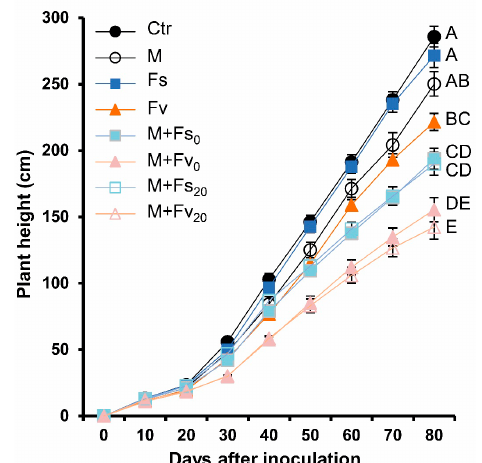
Fig. 3: Effect of Meloidogyne incognita and Fusarium spp. on the plant height of inka nut plants under different treatments during 80 days of vegetative growth measured at 10-days intervals. Error bars indi- cate standard deviation (± S.D.). Columns with the same letter are not significantly different ( p <0.05). Ctrl = control, M=Inoculation with M. incognita, Fs = Inoculation with F. solani, Fv = Inoculation with F. verticilloides, M + (Fs 0 or Fv 0 ) = Simultaneous inoculation of Fusarium species with M. incognita , M + (Fs 20 or Fv 20 ) = Inoculation of Fusarium species 20-days after inoculation with M.